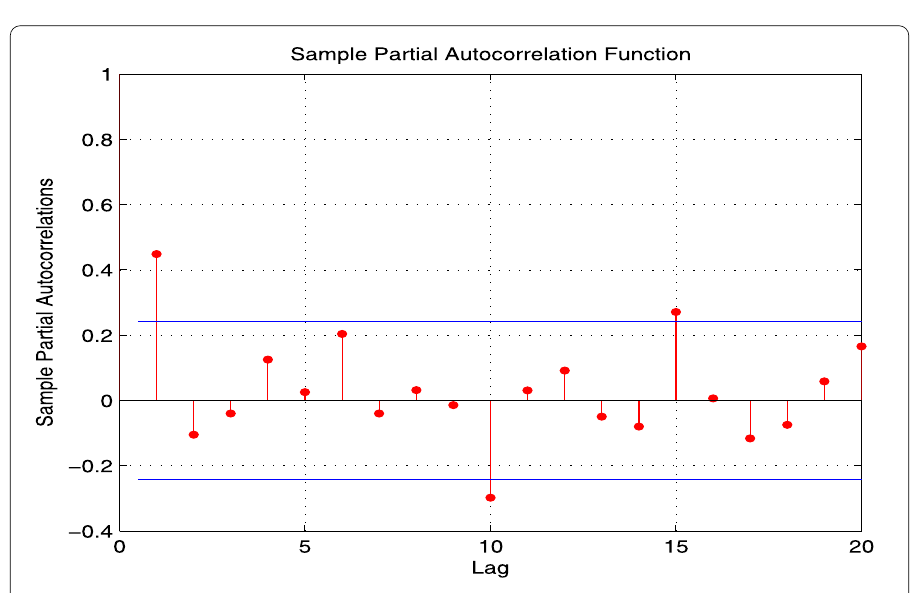
Figure 3 Sample partial autocorrelation function plot of transformed data Y